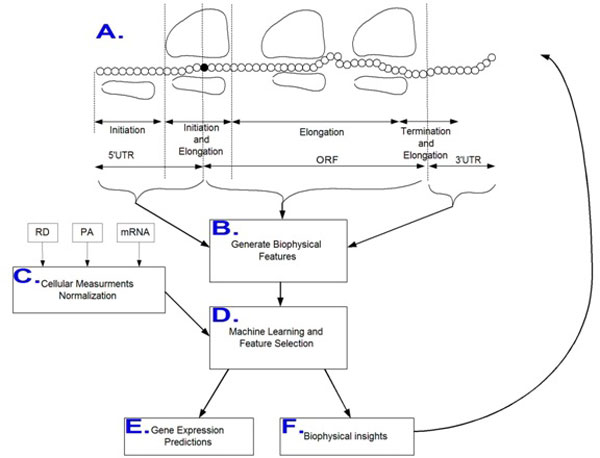
A flow diagram and illustration of the study. A-B. Based on a biophysical understanding of the translation process we extract features from the three parts of the transcript (5'UTR/ORF/3'UTR), corresponding to the three stages of translation (initiation, elongation, termination); but also to other stages in gene expression (transcription, mRNA and protein degradation), and from the entire transcript. C. Large scale cellular measurements of gene expression (mRNA, PA, RD) are collected and normalized. D.-F. Machine learning and feature selection approaches are employed based on the features and cellular data (D.) to infer predictors of gene expression (E. ) and improve the biophysical understanding of the gene expression process, its evolution, and its modeling (F.).